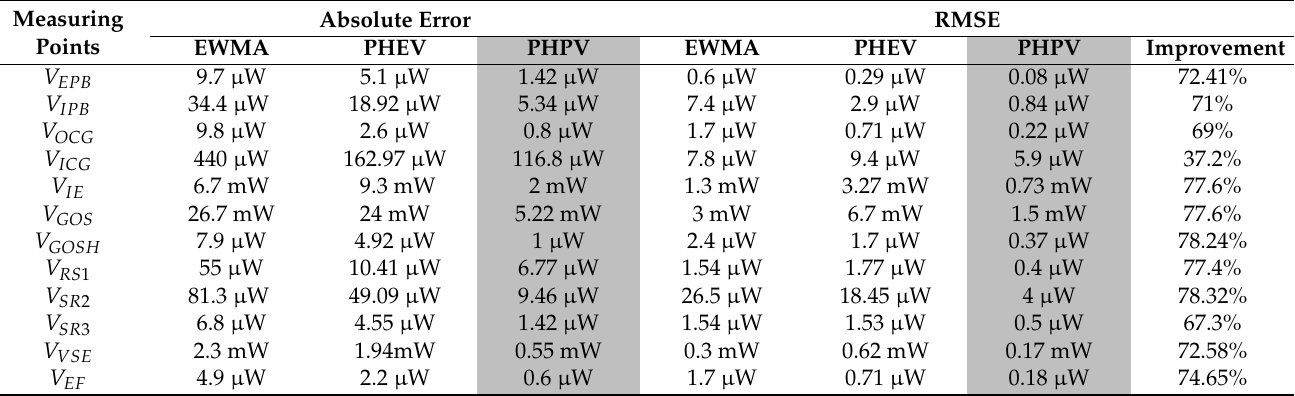
Table 2. Comparison of EWMA and PVHE